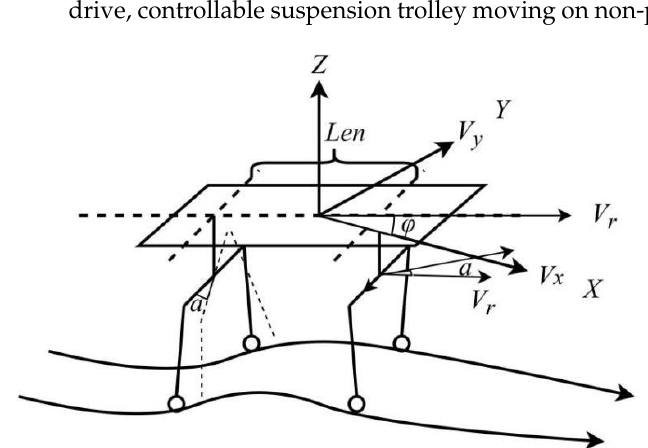
Figure 4. Schematic diagram of trolley movement on non-plane road.